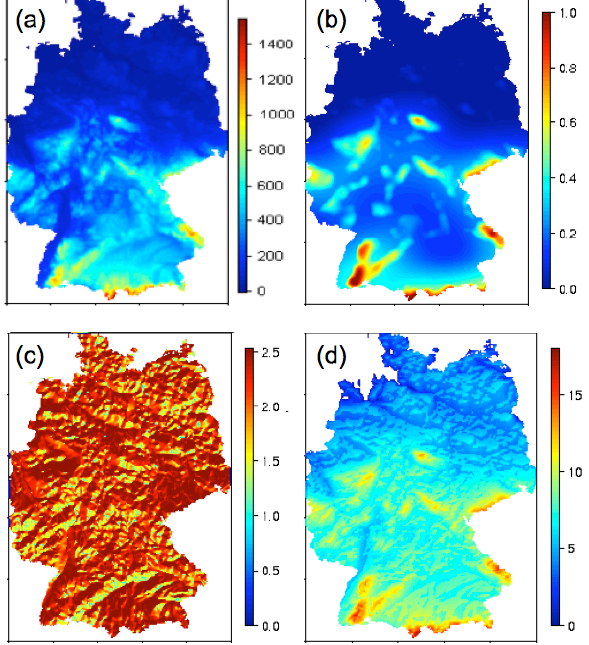
Figure 3. Illustration of terrain features deduced from the DEM: (a) smoothed DEM using Gaussian-filter with radius 5km [m], (b) prominence of terrain, (c) relative facing-value with wind from NW, wind speed > 10m / s, (d) indicator values [–].